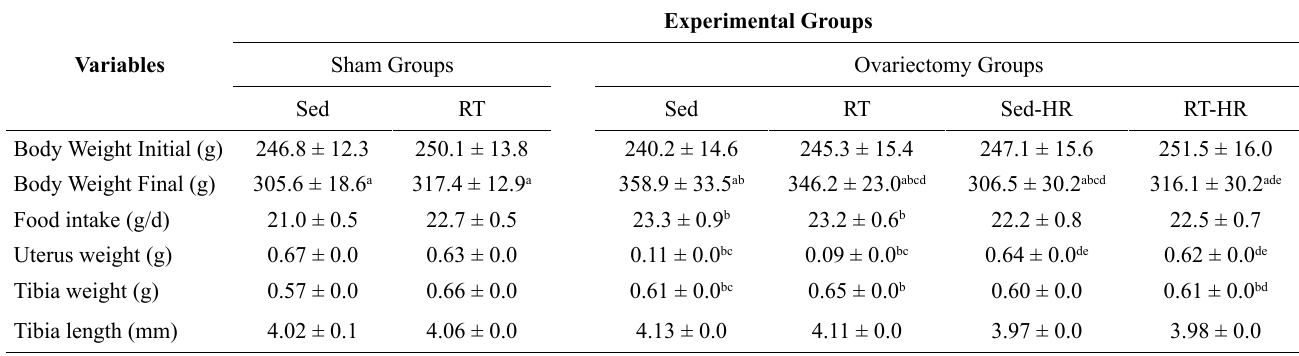
Experimental Groups